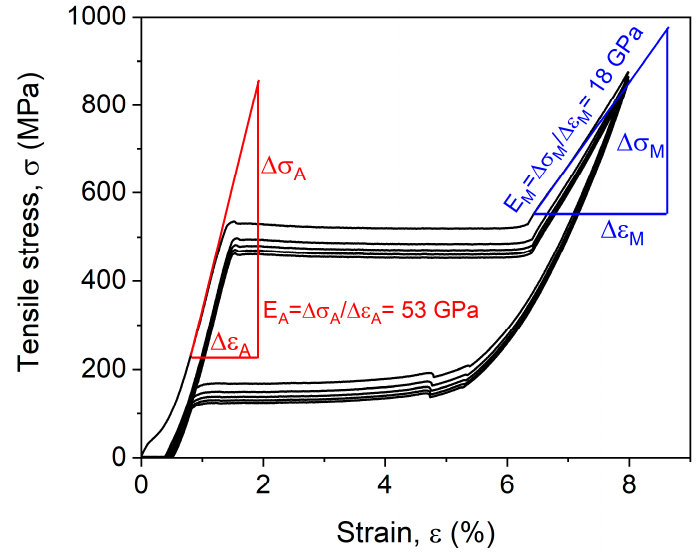
Figure 1. Tensile stress–strain curve of the NiTi wire annealed at 450 °C for 30 min and cyclically loaded/unloaded at room temperature. The elastic moduli, E A and E M before and after the A → M martensitic transformation, respectively, are also shown. Table 1. Material parameters for the NiTi wire used in the present study (annealed at 450 ◦ C for 30